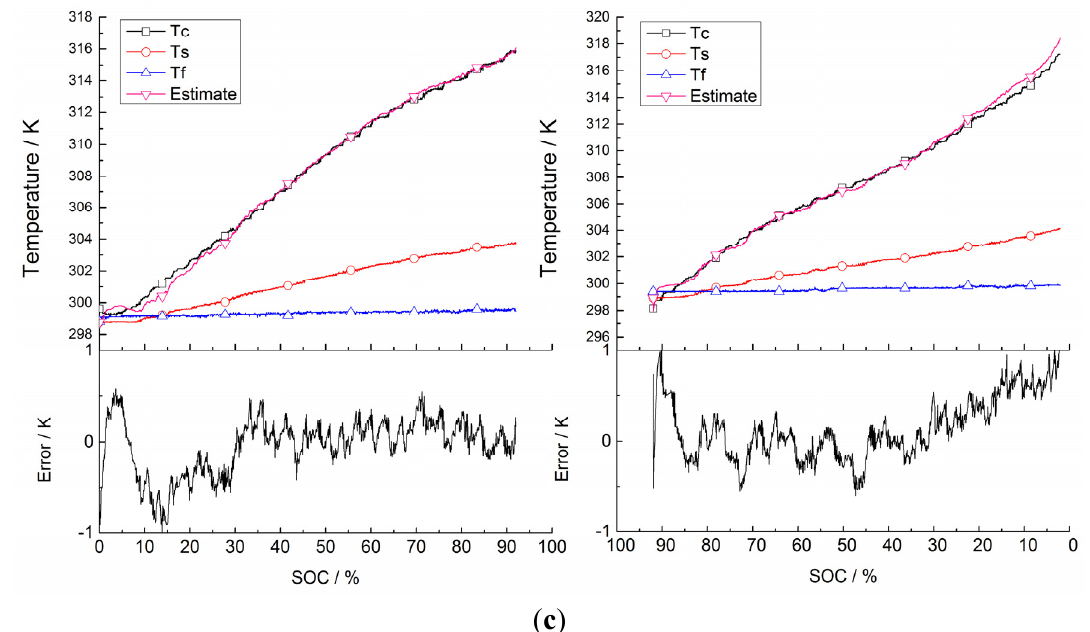
Figure 8. Internal temperature estimation for three current rates. ( a ) Internal temperature estimations for 1 C current rate charge/discharge; ( b ) Internal temperature estimations for 1.5 C current rate charge/discharge; ( c ) Internal temperature estimations for 2 C current rate charge/discharge.